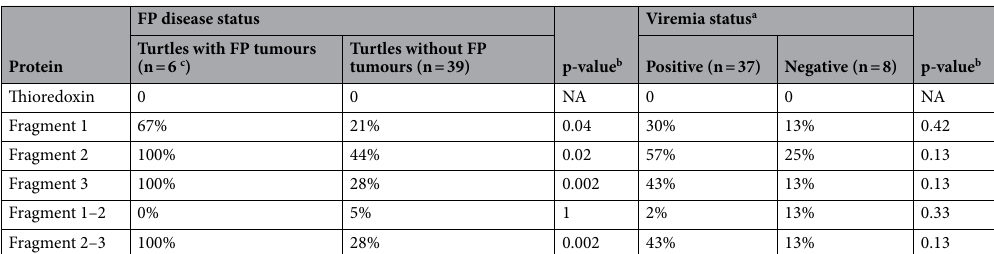
Table 2. Antibody responses were distinct between the sea turtles with and without fibropapillomatosis according to the recognition of the recombinant ChHV5 gB protein. a Determined by PCR using UL18, UL22 or UL27 specific primers. Any of the results showed positive were considered as PCR positive ones and with viremia status. b By fisher’s exact test. c All green turtles.